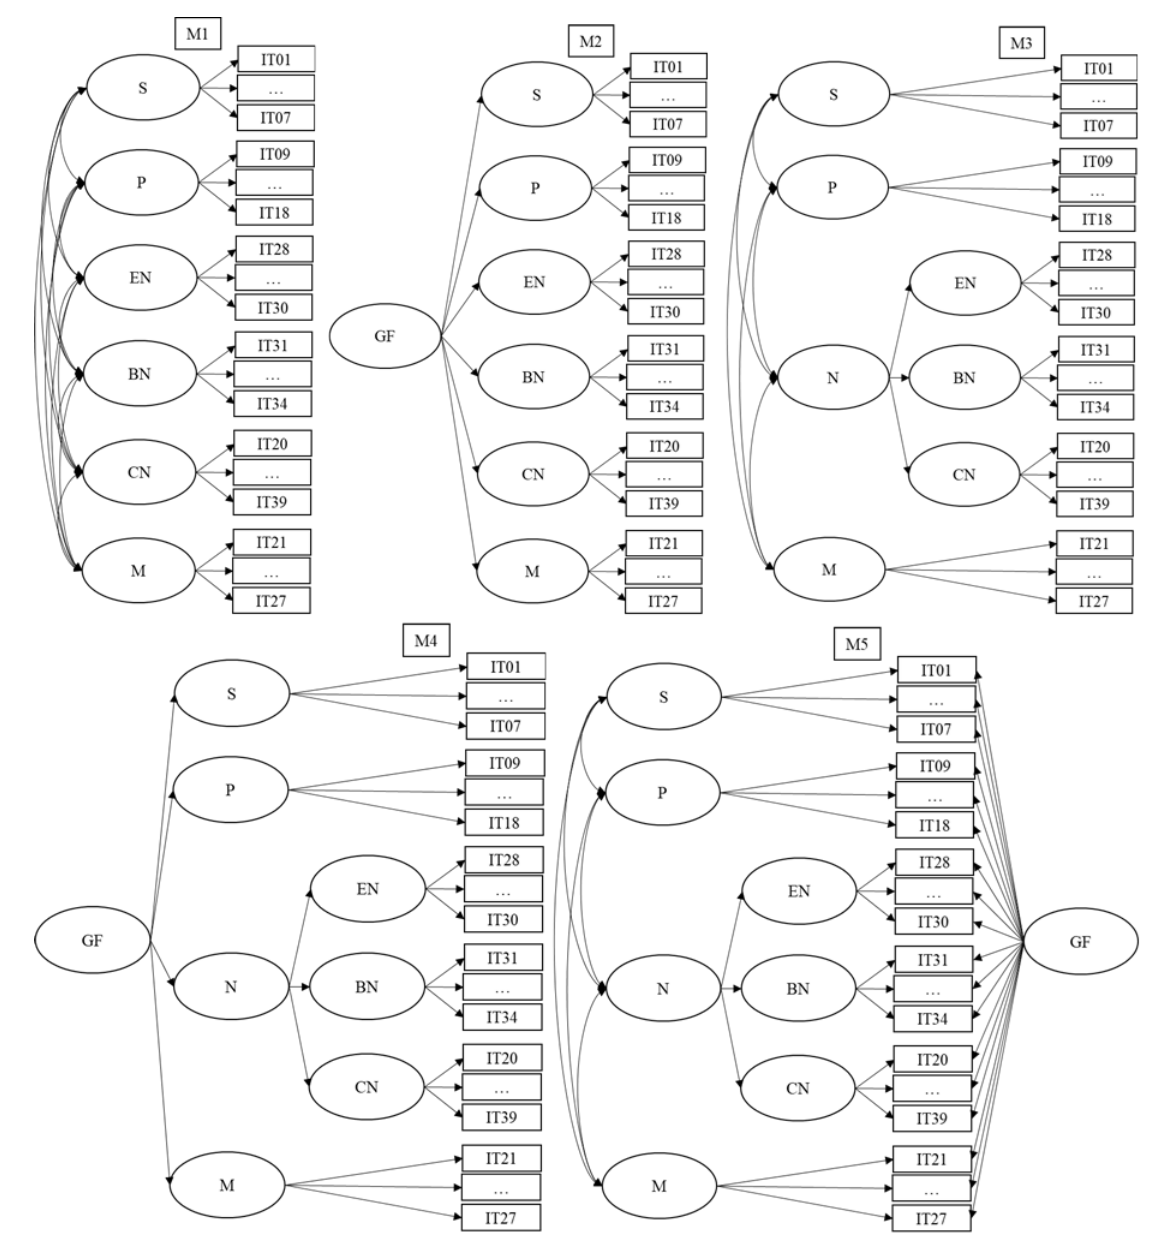
Figure A1. Theoretical factorial models proposed subjected to CFA. Model 1 (M1), oblique 6-factor model; Model 2 (M2), second-order hierarchical model; Model 3 (M3), hierarchical-oblique model; Model 4 (M4), third-order hierarchical model; Model (M5), bifactor Model; S, scientistic; P, positivistic; N, negativistic; EN, emotional negativistic; BN, behavioural negativistic; CN, cognitive negativistic; M, myths; GF, general factor.